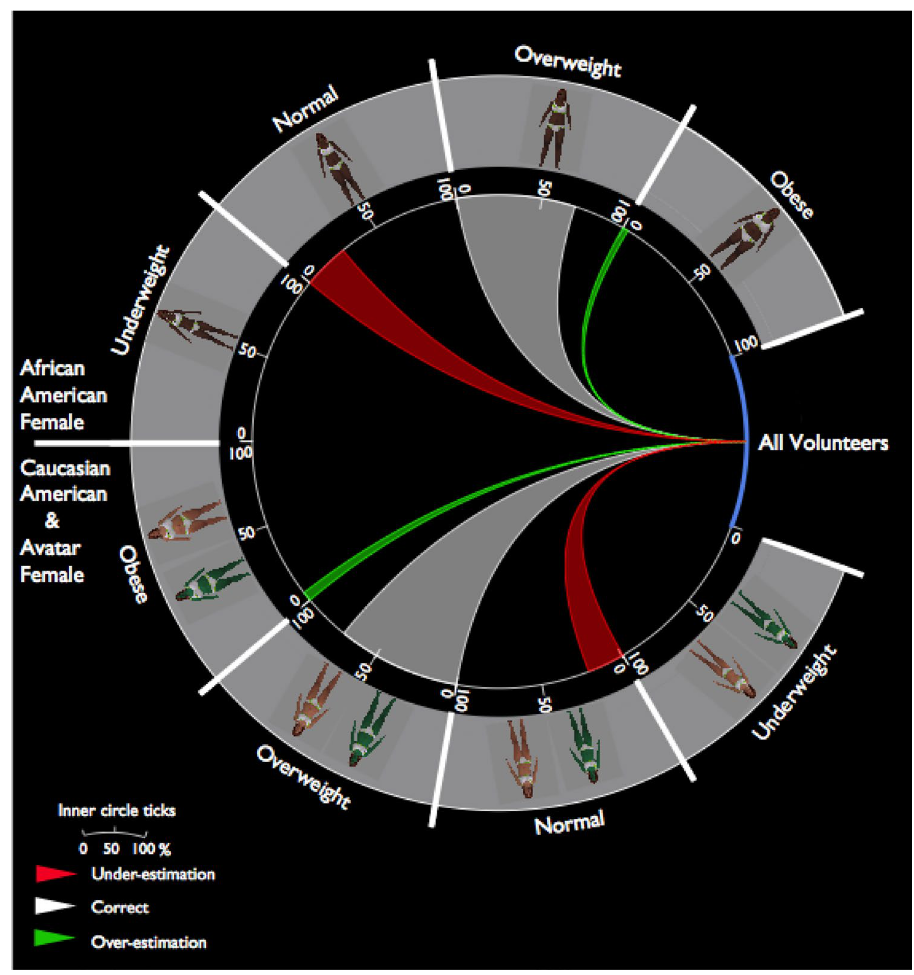
Figure 3. Categorization of Overweight Bodies. Circos 31 plot illustrates the impact of gender and race type of the stimuli during categorization of overweight bodies. Specifically, for female stimuli, participants showed slightly but significantly higher accuracy rate for CA and Avatar bodies than for AA bodies, and they made more under-estimation errors for AA